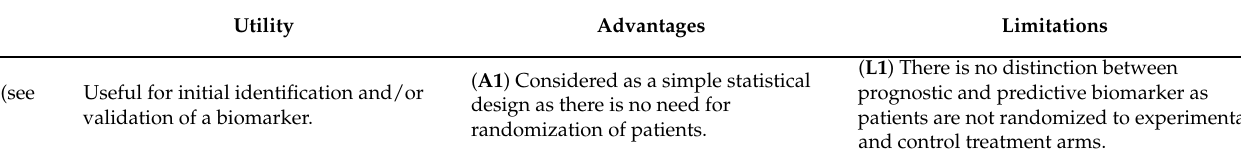
Table 1. Types of Biomarker guided non-adaptive designs proposed within the last ten years. Types of Biomarker-Guided Non-Adaptive Trial